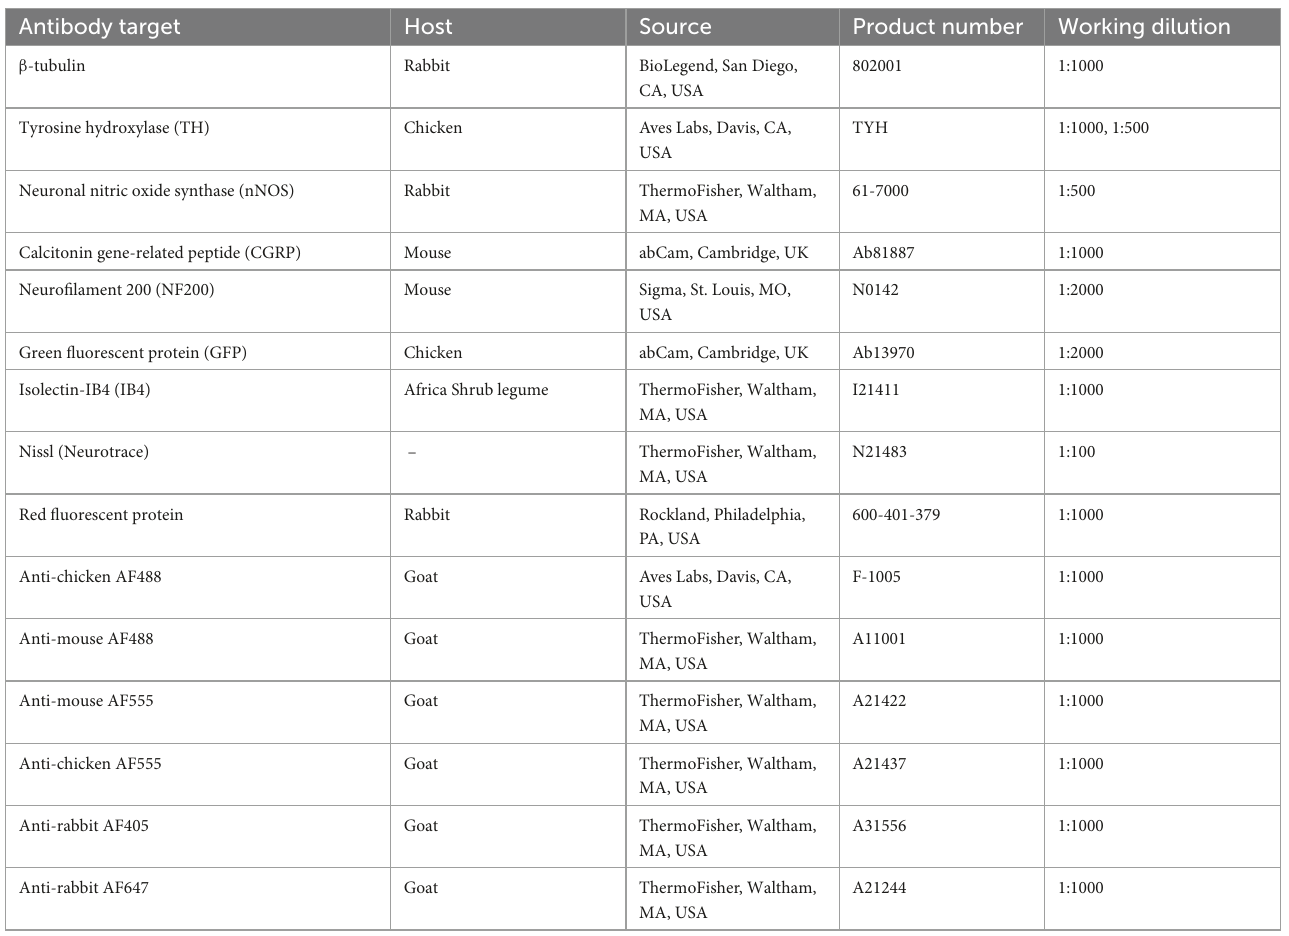
TABLE 1 Antibodies used for